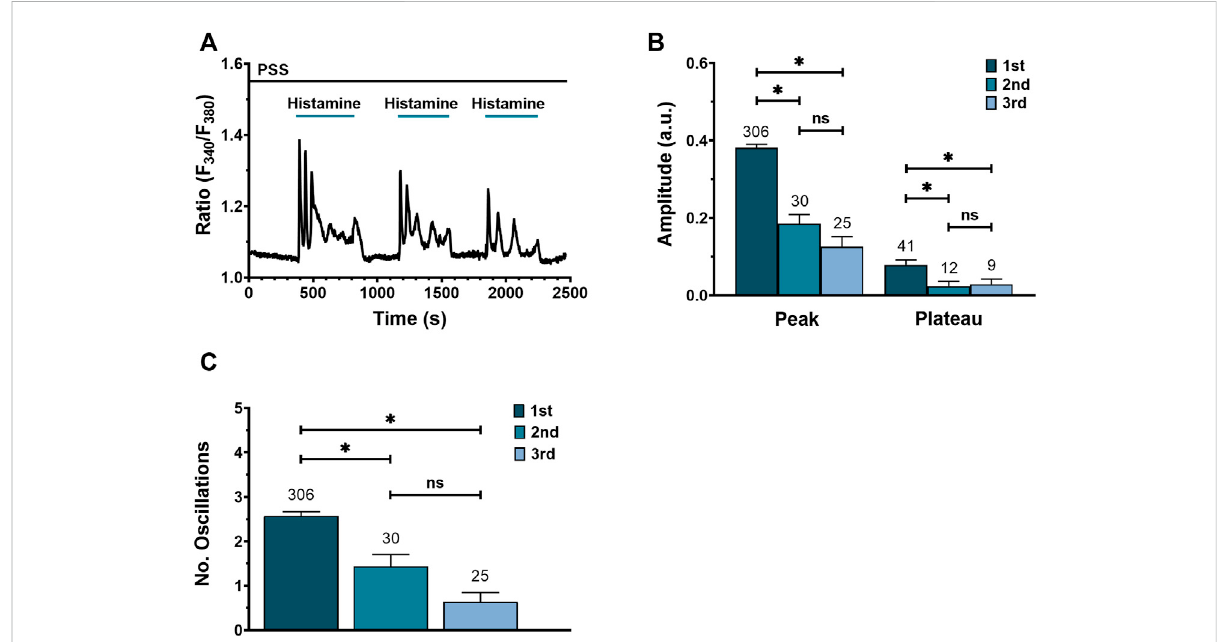
FIGURE 3 Effect of consecutive histamine applications on Ca 2+ signal in WI-38 human lung fi broblasts WI-38. (A) Representative recording of a triple application of histamine (300 μ M) in one cell, each followed by a washout with physiological saline solution (PSS). (B) Mean ± SE of peak and plateau amplitudes of the Ca 2+ transient evoked by 3 consecutive histamine applications: fi rst application (1st), second application (2nd), third application (3rd). (C) Mean±SEofthenumberofoscillationsmeasuredover400 saftereachhistamineapplication.Thenumberinthe fi gurerepresentsthe number of cells studied. Comparison between groups was performed using the Kruskal – Wallis test (* = p ≤ 0.05; ns = no statistically relevant differences between